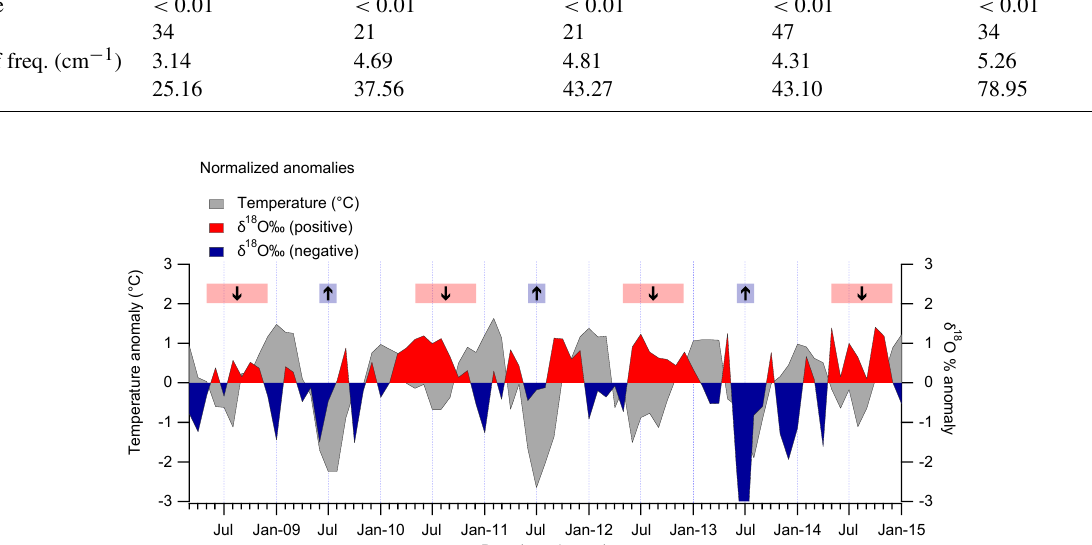
Cut-off freq. (cm − 1 )